Question: In one sentence, what is this figure communicating?
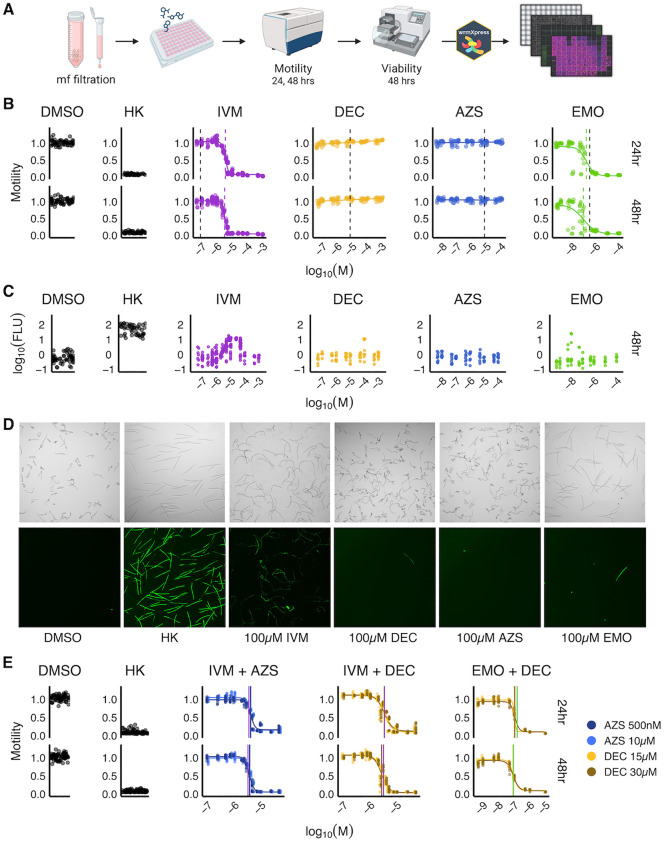
Answer: Brugia mf motility and viability curves for single and combined drug treatments. (A) Schematic depicting the methodology and time points of mf motility and viability data collection. Created in BioRender. Zamanian, M. (2026) https://BioRender.com/h9qes57 . (B) Motility dose response curves 24 hours and 48 hours after treatment with ivermectin (IVM), diethylcarbamazine (DEC), albendazole sulfoxide (AZS), and emodepside (EMO), with dashed lines showing experimental IC50 (color) and therapeutic plasma C max (black) values. Controls include mf treated with 1% DMSO and heat killed (HK) mf. (C) Viability (CellTox Green) fluorescence readings on a log 10 scale across treatment concentrations compared to DMSO and HK controls. (D) Representative brightfield (top row) and CellTox stained (bottom row) images of control and drug treated mf. (E) Motility dose response curves for drug treatment combinations. IVM treatment combined with AZS (500nM or 10µM) or DEC (15µM or 30µM), and EMO treatment combined with 15µM or 30µM DEC. Drug combination IC50s are marked as solid colored lines and IVM plasma C max values as dashed black lines. Individual drug IC50s from (B) are also shown (IVM: purple, EMO: green). Each plot point represents measurements for a plate well containing 1000 mf; each condition was performed across at least four technical replicates (wells) per experiment and each experiment was repeated for at least three biological replicates (parasite cohorts).